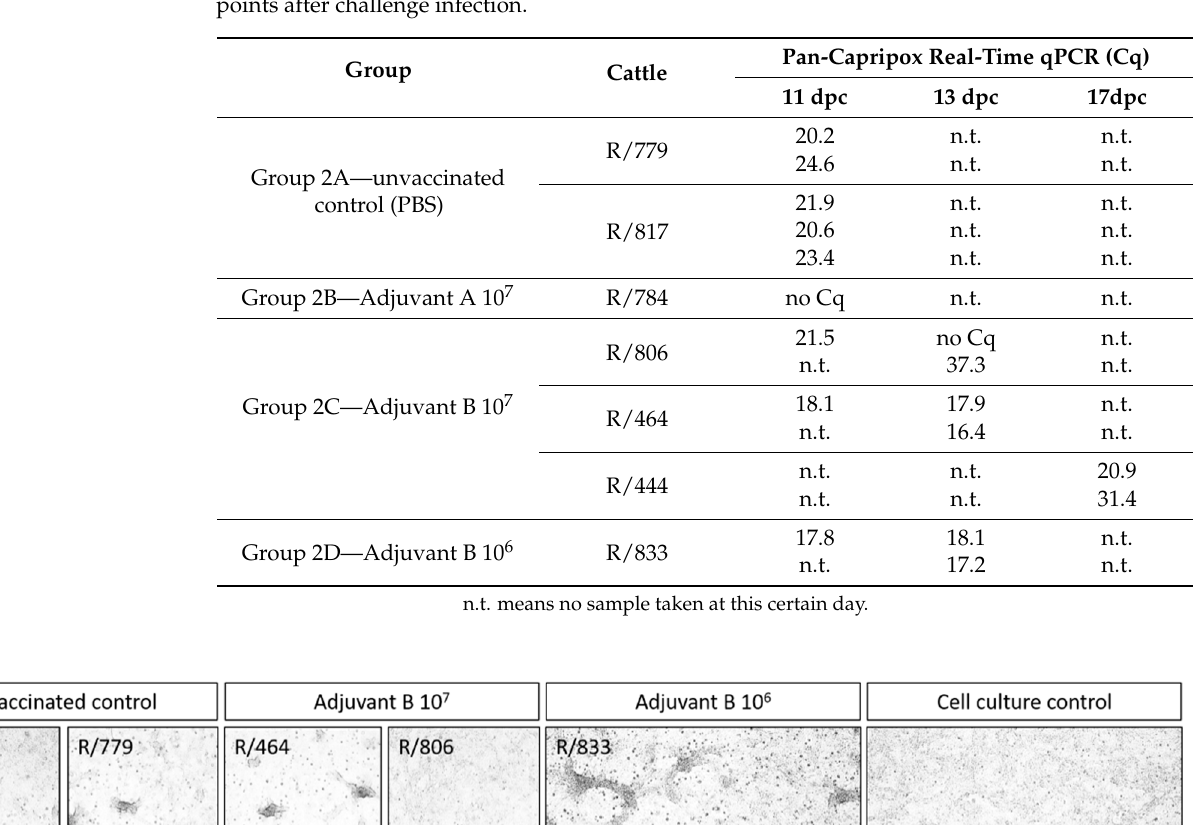
Table 2. Analyses of Capripox virus genome load in samples taken from skin nodes at different time points after challenge infection.